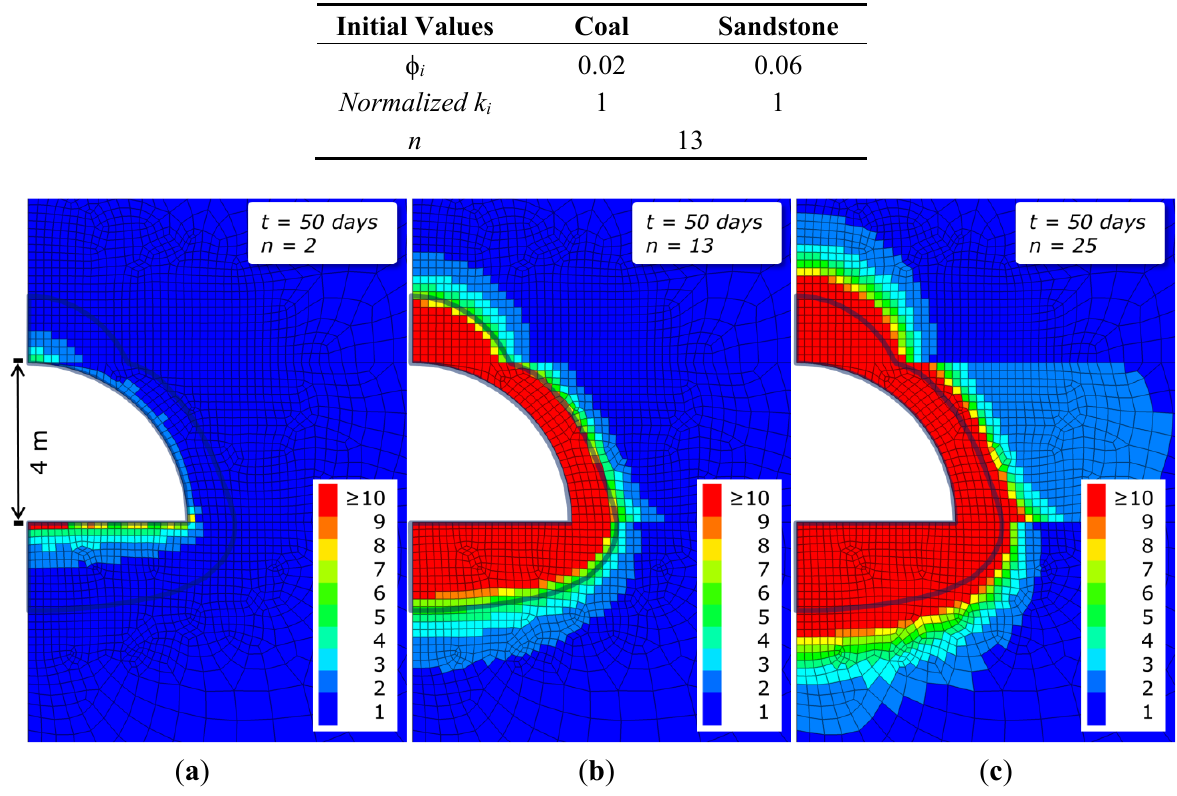
Table 2. Initial averaged data applied for permeability change analysis (from Somerton [54] and Min [42]).